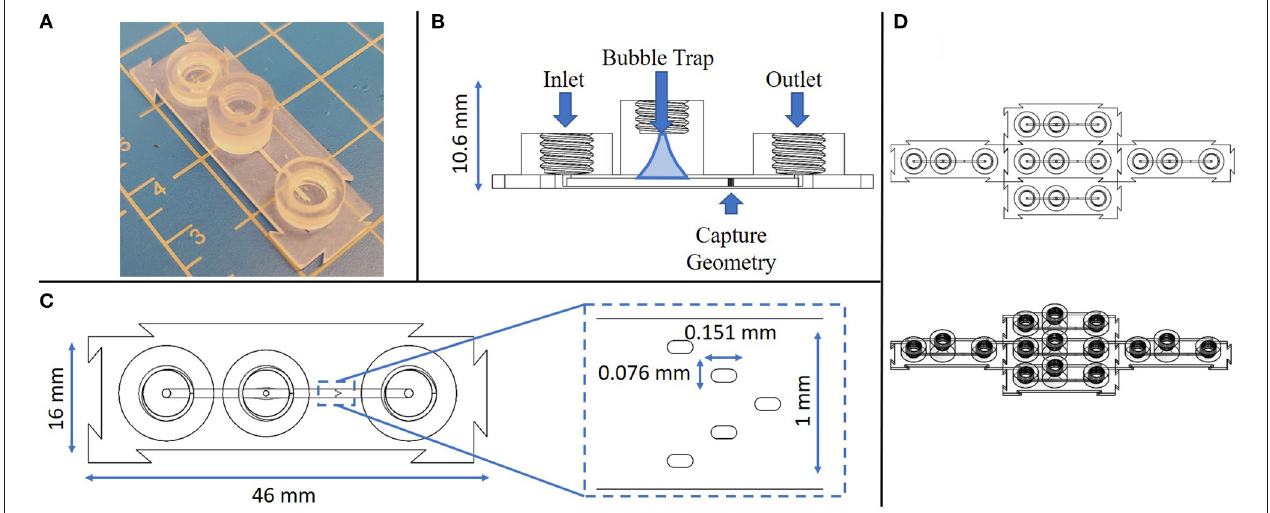
FIGURE 2 | Multiple views of the monolithic spheroid perfusion device with annotations. (A) Isometric view of the device; (B) Cross-sectional view through the center of the device with labels for key features; (C) Top-down view of the device with an expanded view of the capture geometry; (D) Top down view of 5 replicate devices connected via interlocking features at the individual device